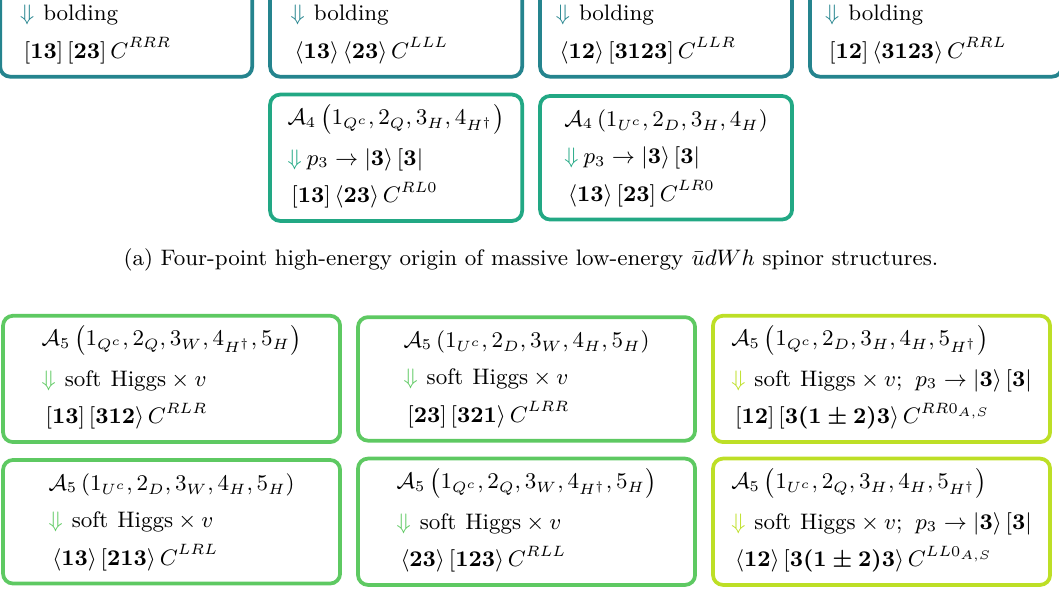
Figure 4 . High-energy origins of the massive low-energy ¯ udWh spinor structures. C are the Wilson coefficients in the LE theory, and their superscripts denote fermion chiralities and the W polarization (for details see text). The different colors categorize the different Higgsing processes ((i), (ii), (iii), (iv)) taking massless SMEFT contact terms to massive